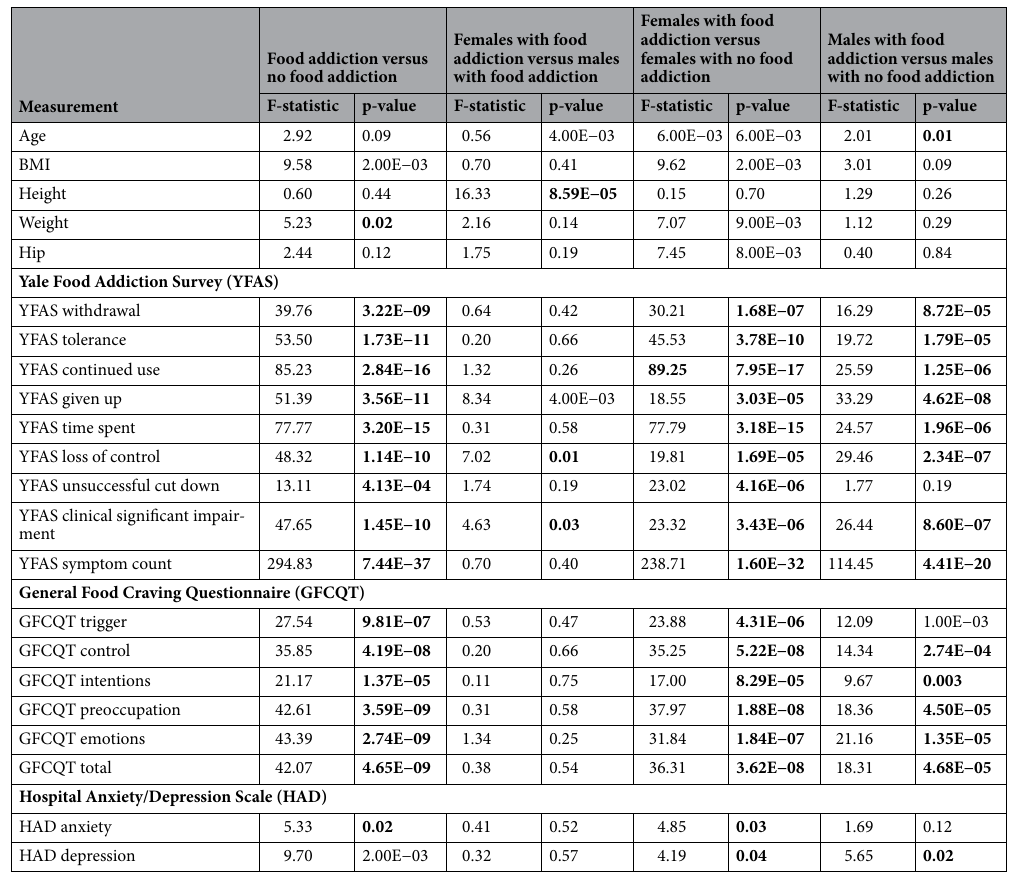
Table 2. Group differences in demographics and clinical behavioral measures. BMI, Body Mass Index; GFCQT, General Food Cravings Questionnaire—Trait; HAD, Hospital Anxiety and Depression Scale; YFAS, Yale Food Addiction Scale. p-value significant < .05. All significant group differences in demographics and clinical behavioral measures for individuals with food addiction (females and males) and individuals with no food addiction (females and males). All bolded values are significant p < 0.05.